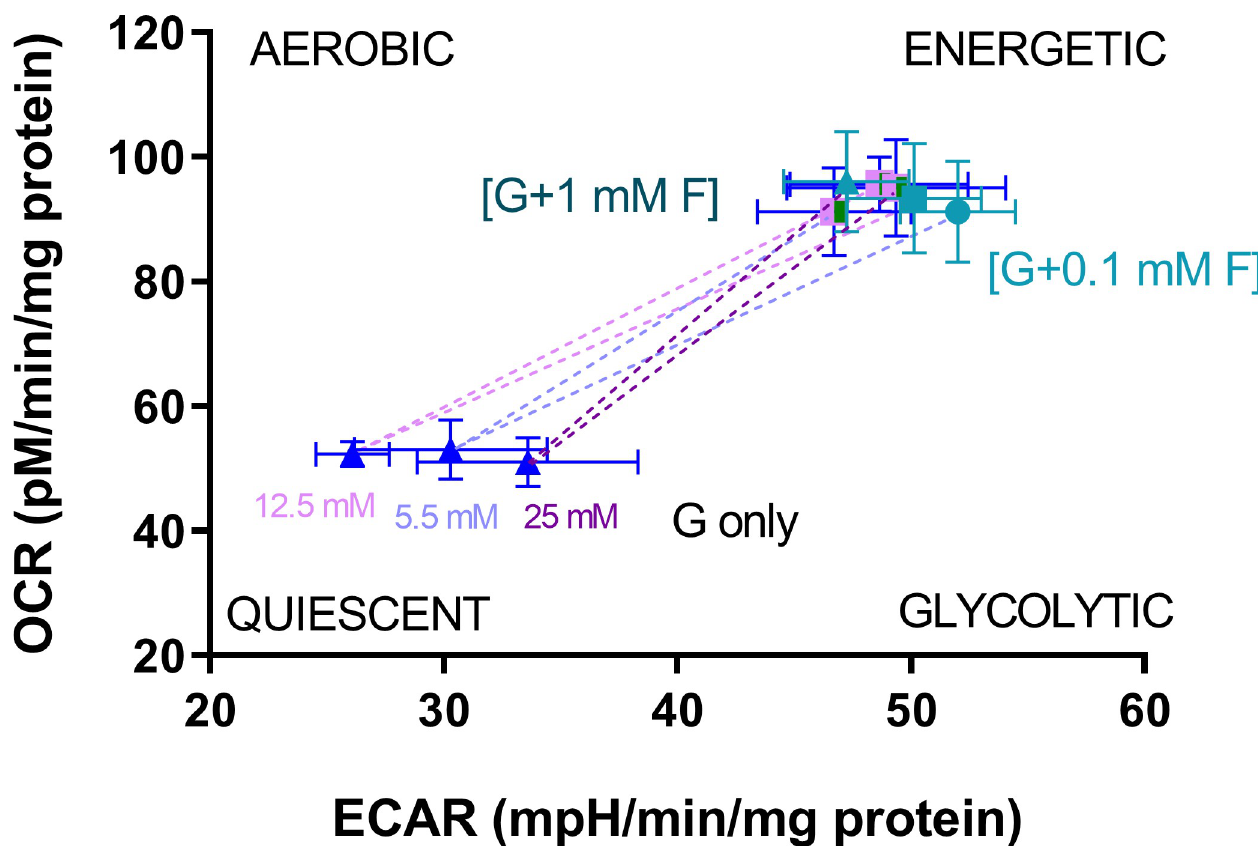
Fig 4. Energy map. Energy map for cells treated with intermittent glucose and glucose/fructose. Dotted lines represent the direction of change induced by fructose substitution for glucose (0.1 mM–light symbols; or 1 mM–dark symbols) in cells treated with different glucose concentrations. Data are expressed as mean ± SEM (n = 8–12 for each mean depicted).